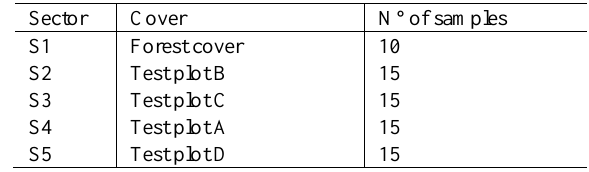
Table 2. Characteristics of the four test sectors.